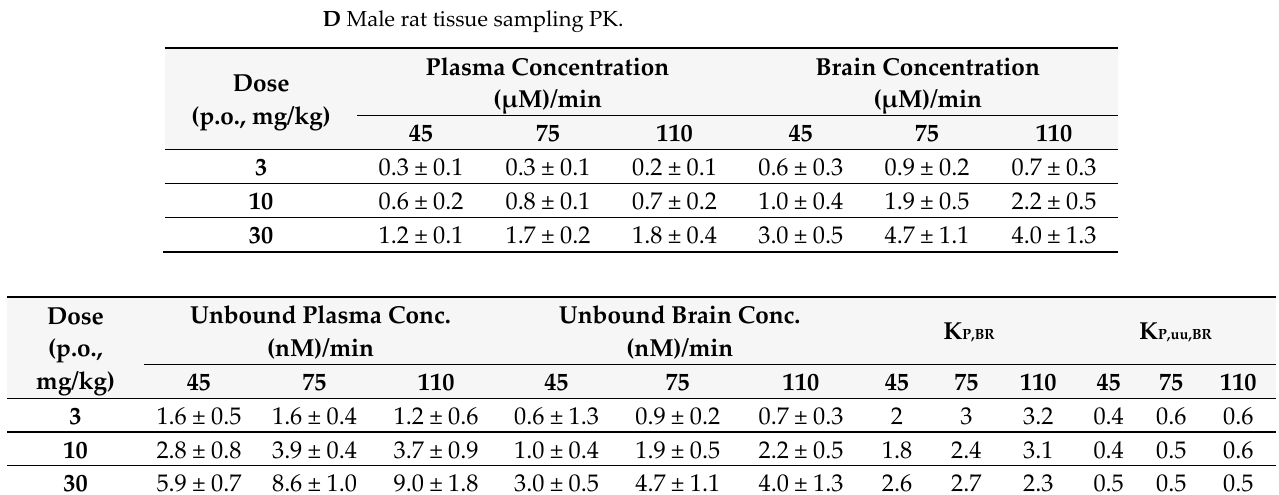
D Male rat tissue sampling PK.